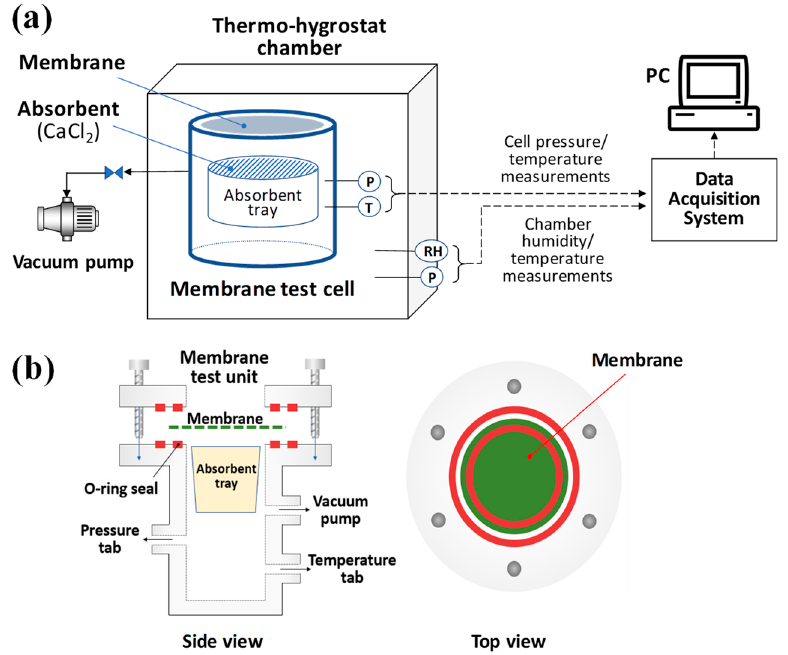
Figure 2. Experimental setup of membrane performance test facility ( a ) Schematic diagram ( b ) Side and top view of membrane test cell.